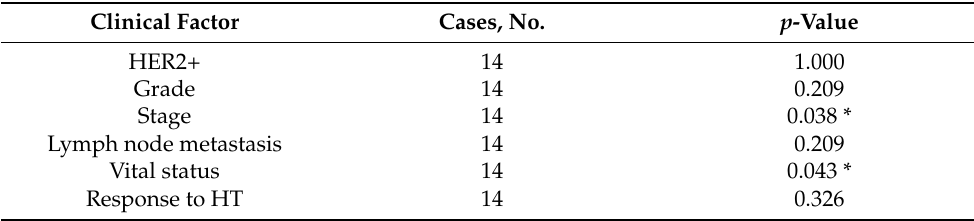
Table 8. Correlation between BiP subcellular localization and clinical factors in IPOP’s cohort 1. Clinical Factor Cases,